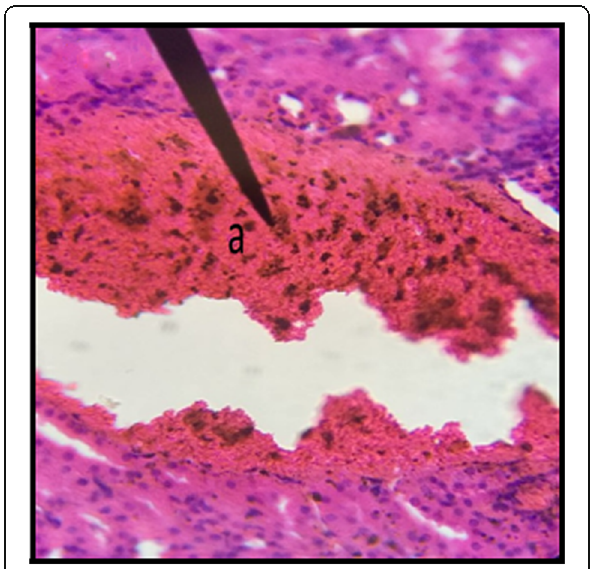
Table 4. Embelia (Embelia ribs) has strong ability on dys- lipidemia associated with hypercholesterolemia. It re- duces cholesterol and TG levels [38] at dose of 50 mg/kg/ day presented in Table 5. Belericmyrobalan (Terminalia belerica) increases body weight and decreases serum chol- esterol, triglycerides, uric acid and creatinine [39] that was also observed during sub-acute toxicity study at dose of 50 mg/kg/day in both male and female rats (Figs. 1 and 2).